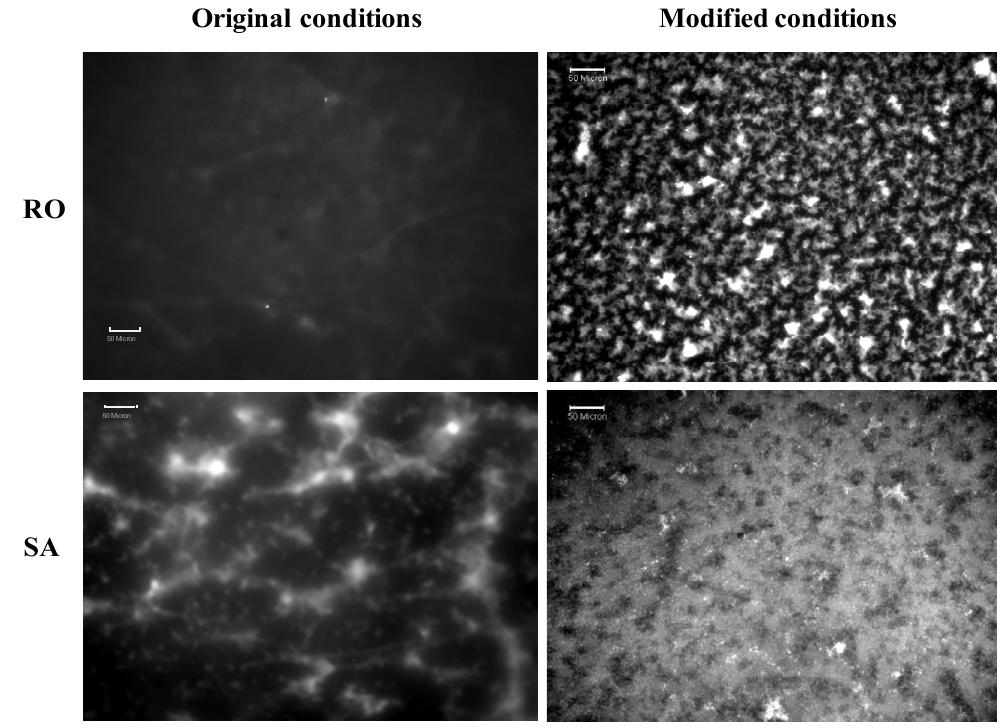
Figure 5. Comparison of SB dye binding in chitosan (CHI)/hyaluronan (HA)/DNA films with either random oligomer (RO) (top) or SA (bottom) after exposure to 200 µM SB dye. Images were taken by FM ( λ = 594 nm) tracking the fluorescence of SB dye. Films were em prepared by the original method (left) and modified method (right) of deposition and were imaged dry. Scale bar, 50 µm. Original conditions Modified